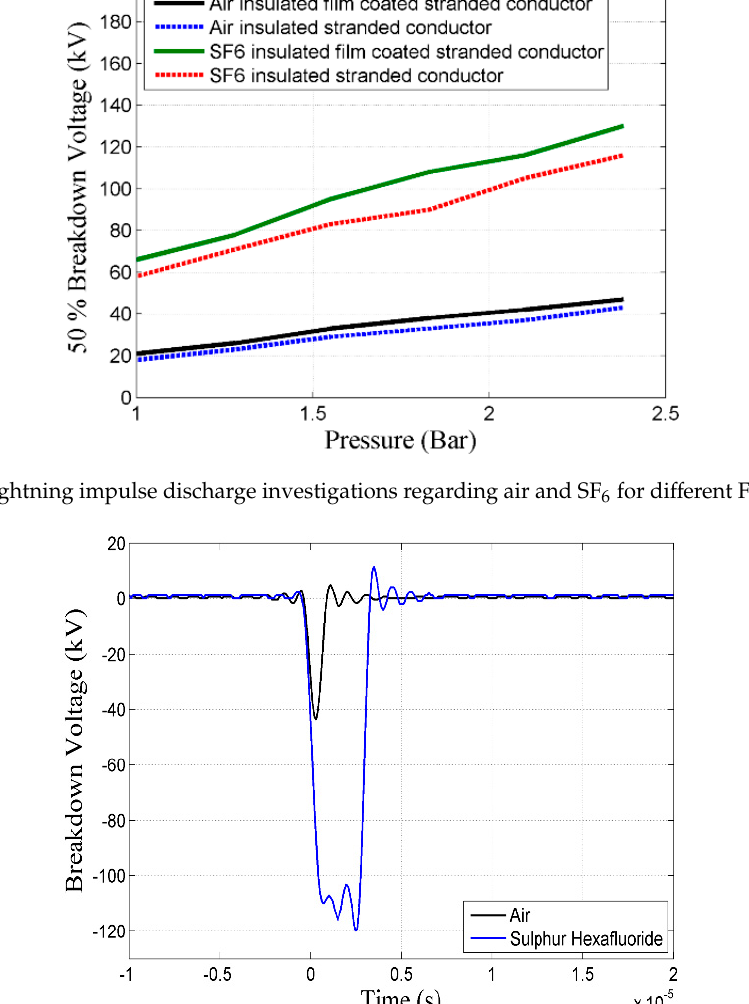
Figure 22. Measured lightning impulse discharge voltage regarding air and SF 6 in fabricated FGIL model at 2.38 bar.